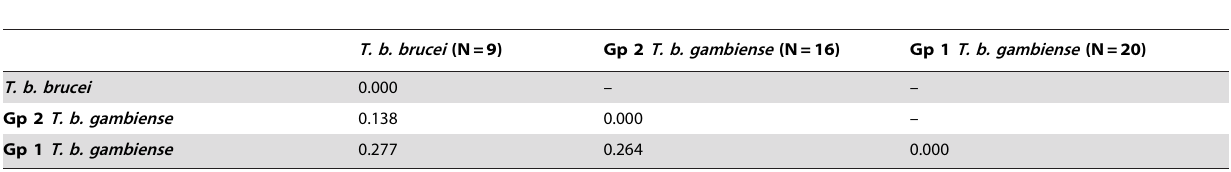
Table 4. F st proportion indicating genetic distance between the populations of group 1 and 2 T. b. gambiense and T. b. brucei at the Coˆte d’Ivoire